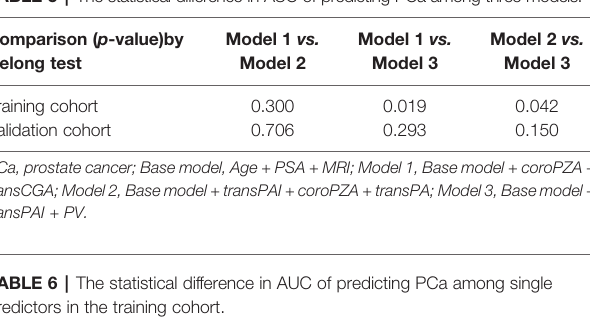
PCa, prostate cancer; AUC, area under the curve; PA, prostate maximum sectional area; CGA, central gland sectional area; PZA, peripheral zone sectional area; PAI, PZA-to-CGA ratio; trans, transverse; coro, coronal; PV, prostate volume; Base model, Age + PSA + MRI; Model 1, Base model + coroPZA + transCGA; Model 2, Base model + transPAI + coroPZA + transPA; Model 3, Base model + transPAI + PV.